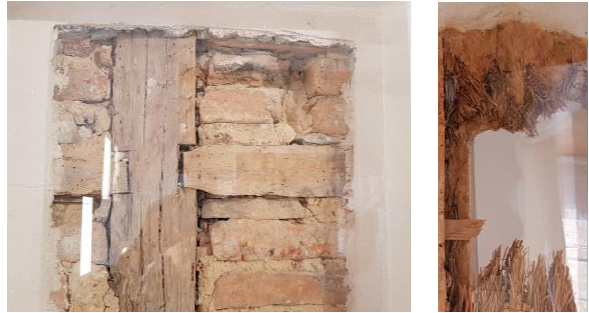
Figure 17. Half-timbered houses with large openings in the façade in Pascual Veiga Street. Source: A.F.P.